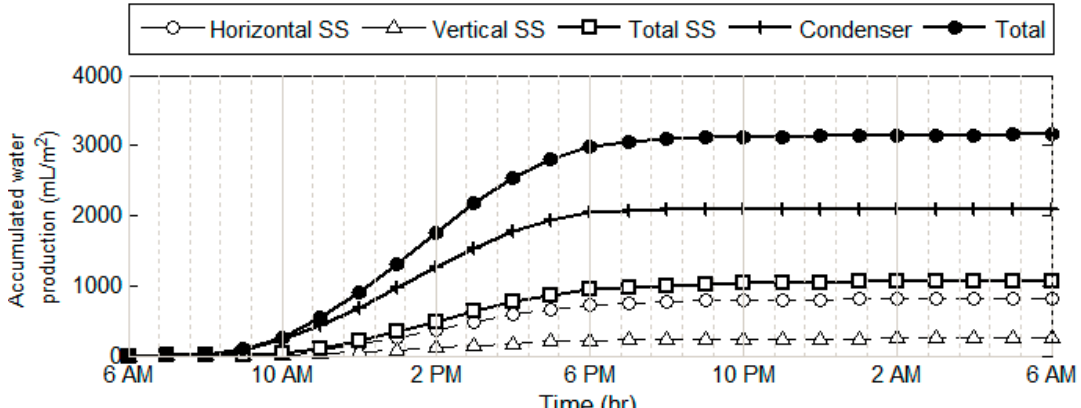
Figure 24. Accumulated water production from different resources—Egyptian GH—for a typical day of 21st March, Borg El-Arab, Egypt.